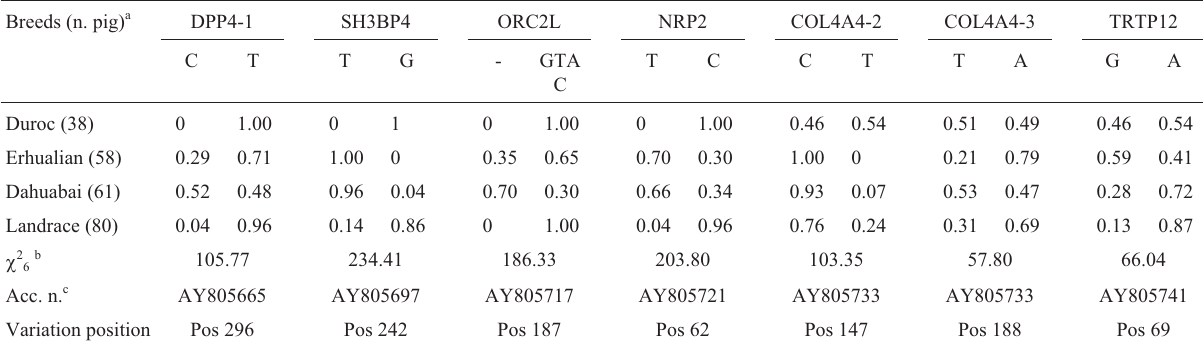
Table 2 - Allele frequencies of the 7 polymorphic sites in 4 pig populations and Pearson’s (cid:4) 2 value. Breeds (n. pig) a